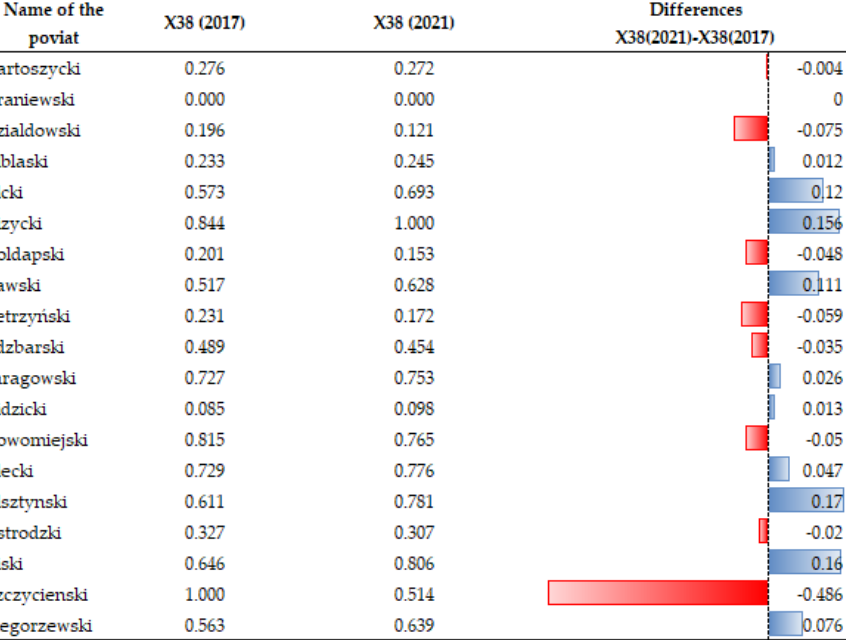
Figure 8. Changes in the index of the electricity consumption/ per person (X38) in individual spatial units. Source: own study on [106].